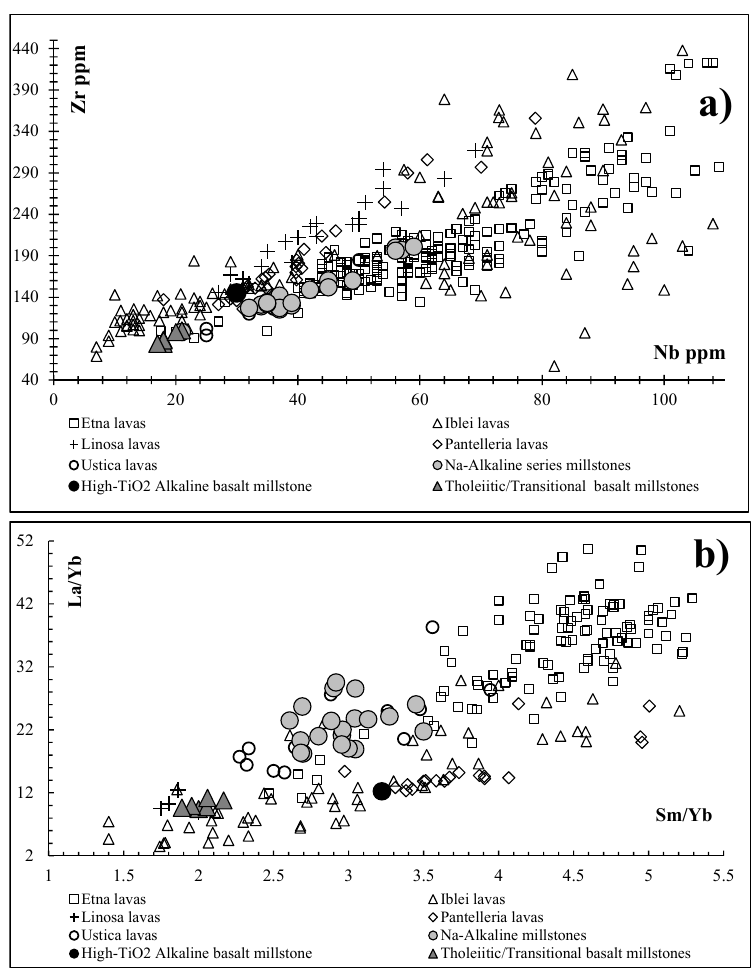
Figure 7. Nb vs. Zr ( a ) and Sm / Yb vs. La / Yb ( b ) diagrams comparing the investigated millstones with selected ocean island basalts (OIB) lavas from the Mediterranean—Etna, Iblei, Linosa, Pantelleria and Ustica (literature data from [49]).